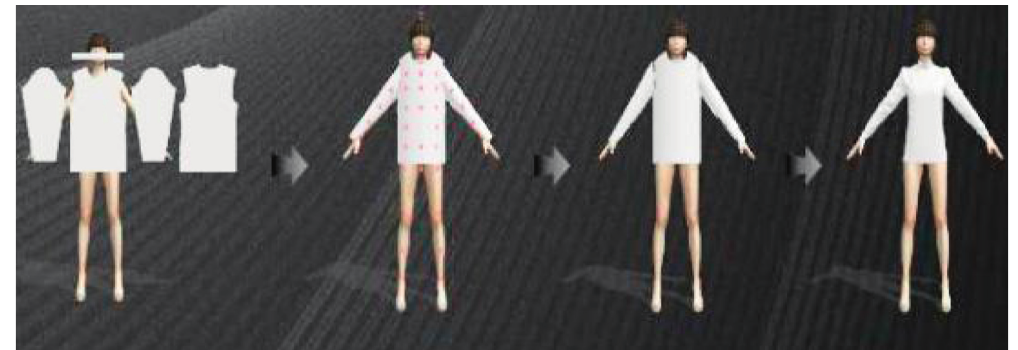
Figure 1: 3D fitting process based on computer simulation